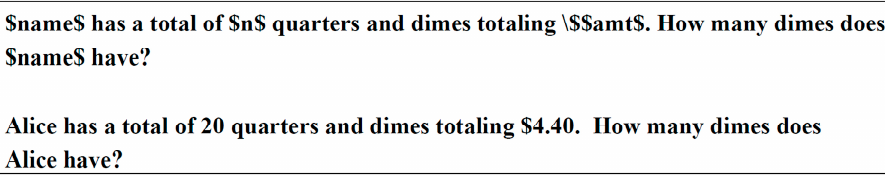
Figure 2. LiquiZ randomized word problem.